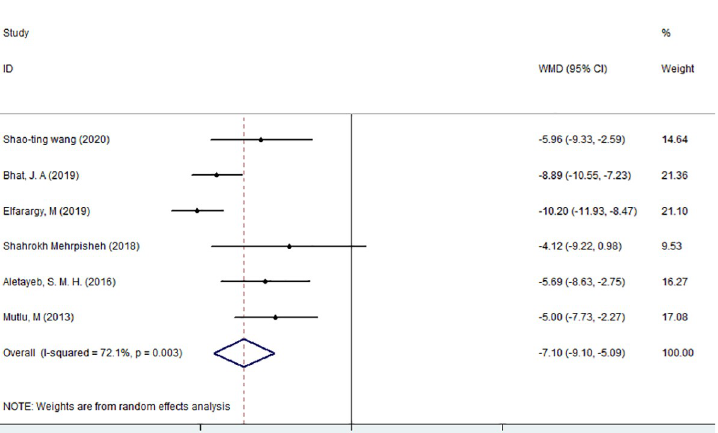
Fig 2. Meta-analysis of the correlation between vitamin D and neonatal hyperbilirubinemia in general.